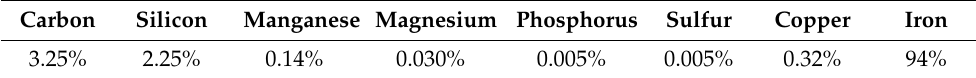
Table 1. The chemical composition of ductile cast iron.